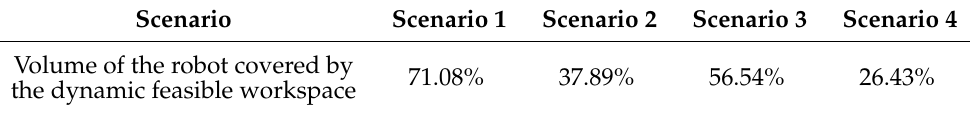
Figure 6. Dynamic feasible workspace of the robot in different scenarios. ( a ) Scenario 1. ( b ) Scenario 2. ( c ) Scenario 3. ( d ) Scenario 4. Table 2. Comparison of the dynamic feasible workspace in different